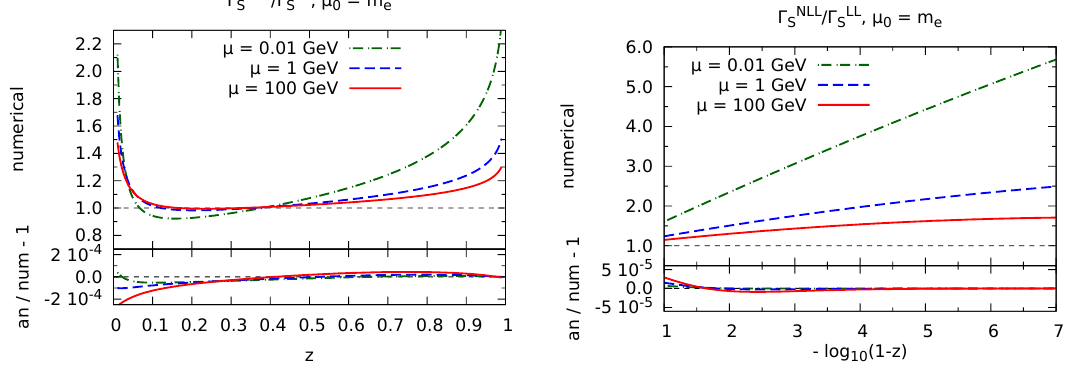
Figure 10 . As in (cid:12)gure 9, for the singlet.